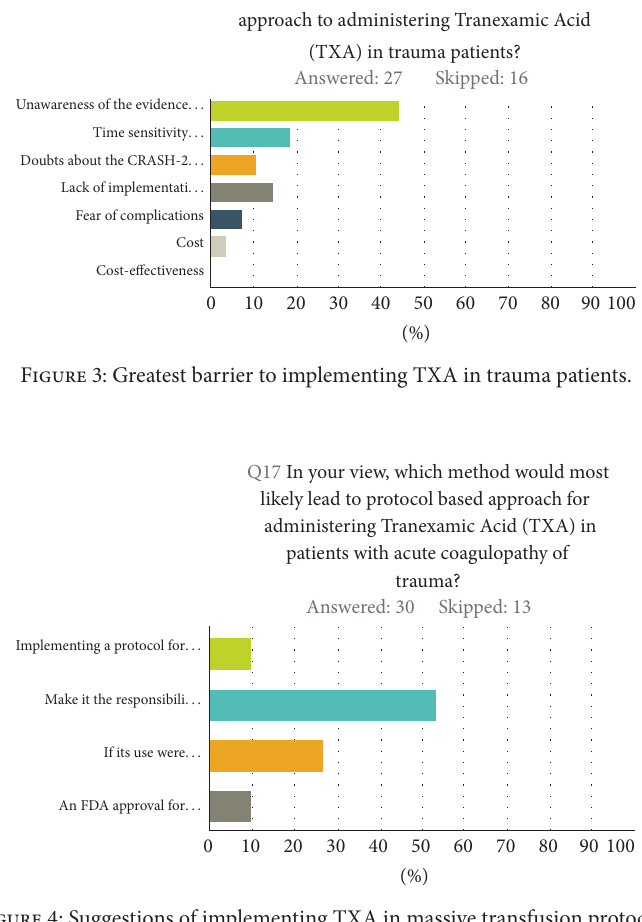
Figure 4: Suggestions of implementing TXA in massive transfusion